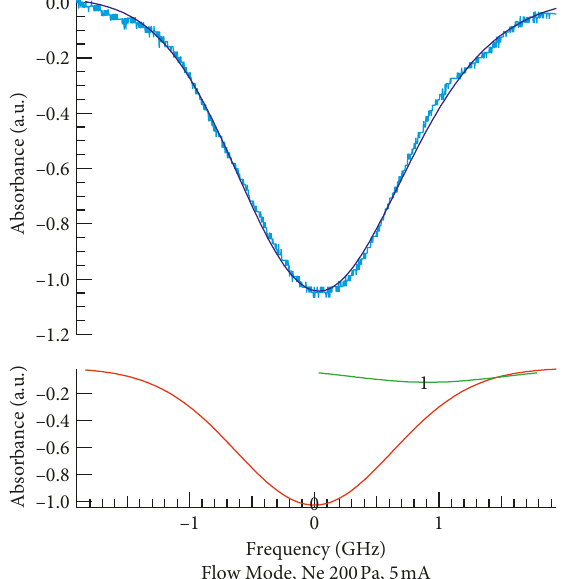
2 [3/2] O ( J 1) 3/2 )3s (cid:31)